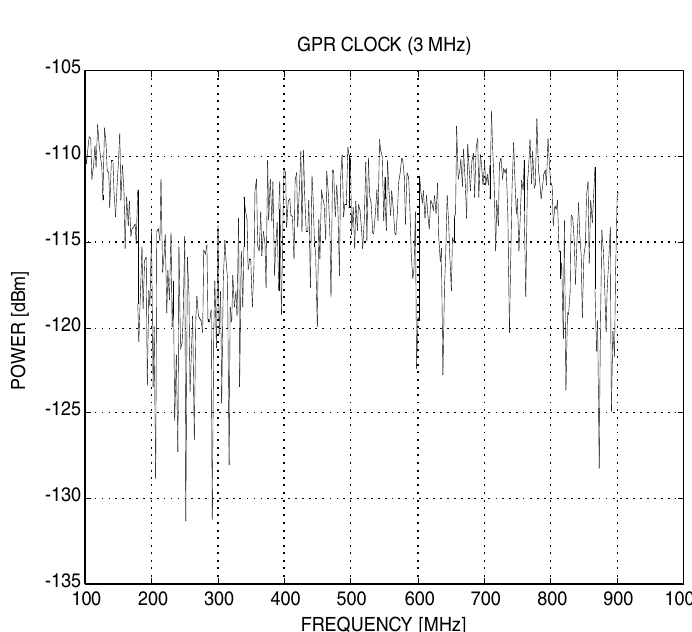
Fig. 4. Result of an averaging performed on the noise generated by the timing system.